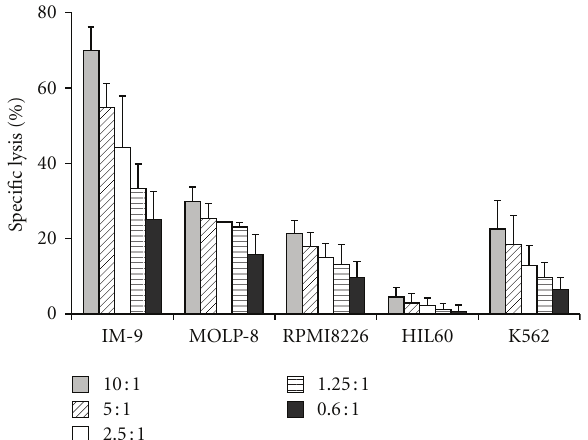
Figure 4: NK-92 mediated killing of target cell lines is dependent on applied E:T ratio. CRA revealed a clearly E:T-dependent level of NK-92 mediated cytotoxicity. Results of CRA are represented as means of at least three independent experiments ± SD. Values in the table below are given as % specific lysis. AML cell line HL60 was almost resistant to NK-92 mediated killing. NK-92 cells were stimulated with 200 U/ml IL-2 the day before the